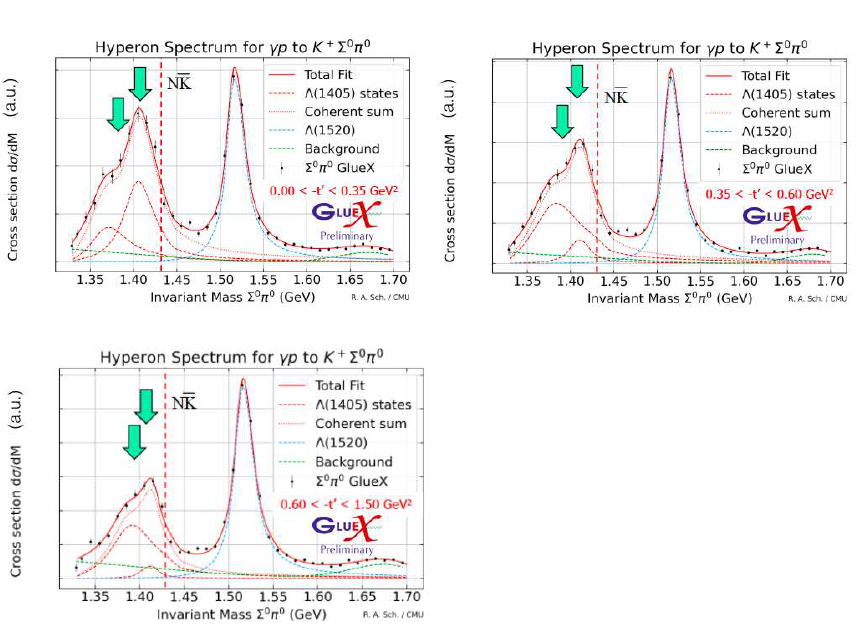
Figure 4: The di ff erential cross section d σ / dM Σ 0 numerical scale since the absolute normalization has not been fi nalized. Red vertical dashed lines indicate the N ¯ K threshold. Green arrows indicate centroid